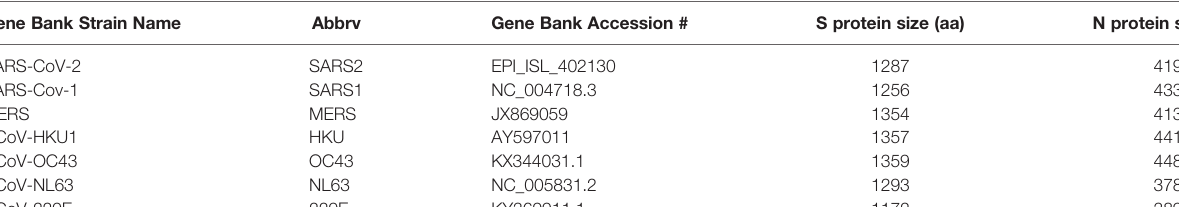
TABLE 1 | Gene sequences of HCoV spike and nucleocapsid